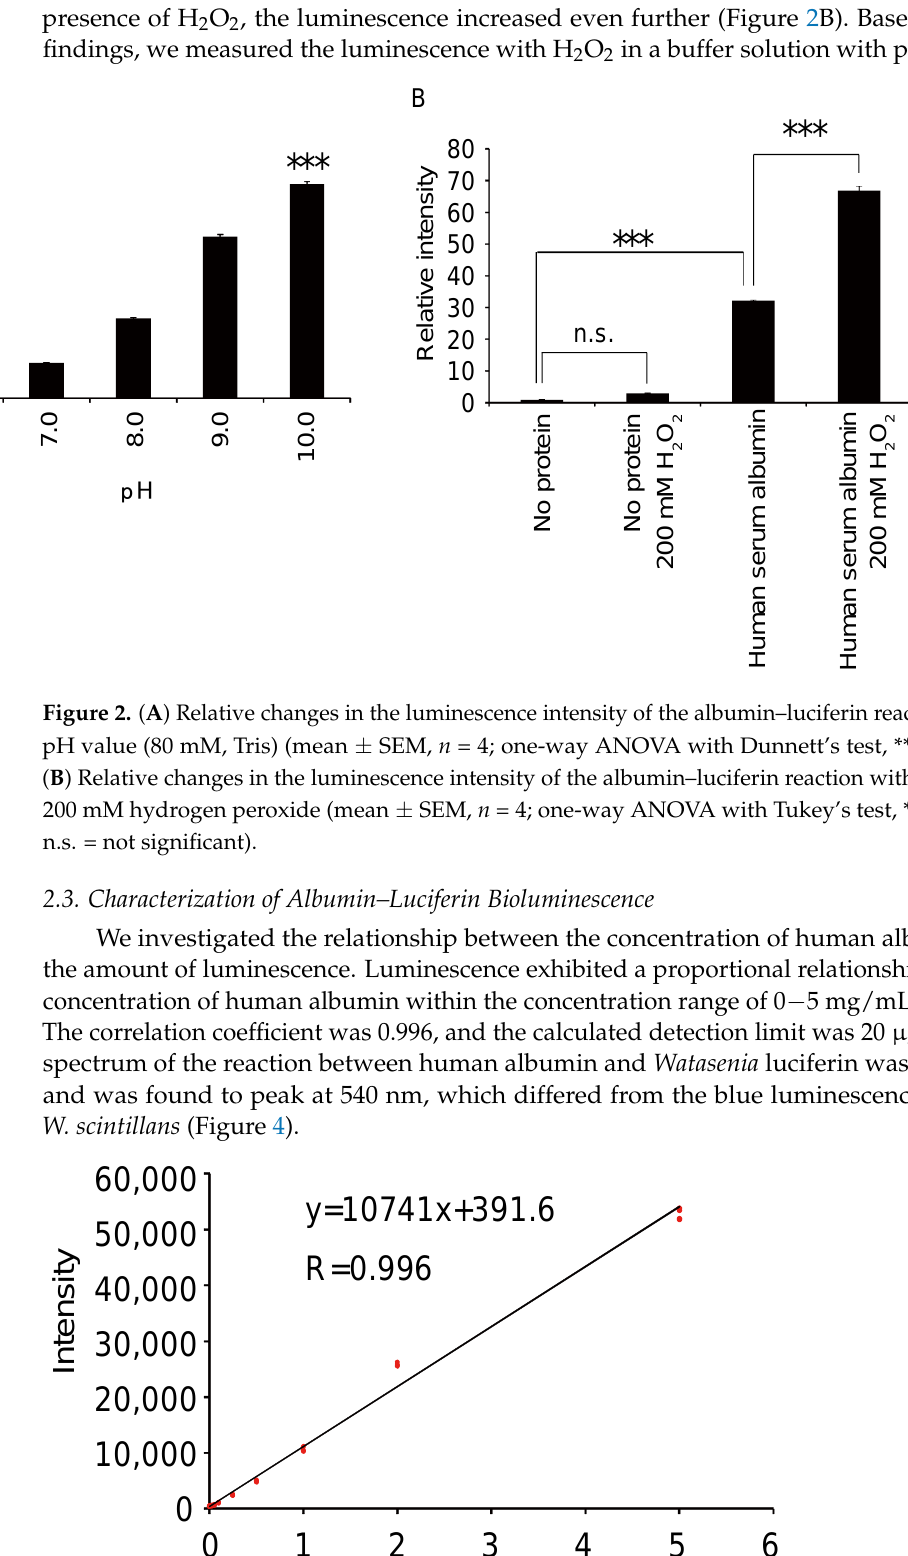
Figure 4. Luminescence spectrum of the albumin – luciferin reaction. We then determined the manipulations that would inhibit the luminescence to characterize the albumin – luciferin reaction. When the human albumin was heat-denatured, the amount of luminescence decreased depending on the duration of heat treatment (Figure 5A). This indicates that albumin loses its luminescence ability when its higher-order structure is destroyed by thermal denaturation. However, the signal in the immunoturbidimetric assay showed no significant decrease, even with the albumin that was heat-denatured for 30 min (Figure 5B). When the albumin was treated with different concentrations of trypsin and a serine protease and reacted with luciferin, the amount of luminescence decreased according to the trypsin concentration (Figure 5C). This indicates that the partial cleavage of the pep- tide by trypsin leads to the loss of luminescence ability. When the same trypsinized samples were measured through the immunoturbidimetric assay, the signal decreased depending on the trypsin concentration, but the decrease was milder than that in the re- action with luciferin (Figure 5D). These results indicate that the immunoturbidimetric method is more resistant to the partial cleavage of albumin than the albumin – luciferin reaction.